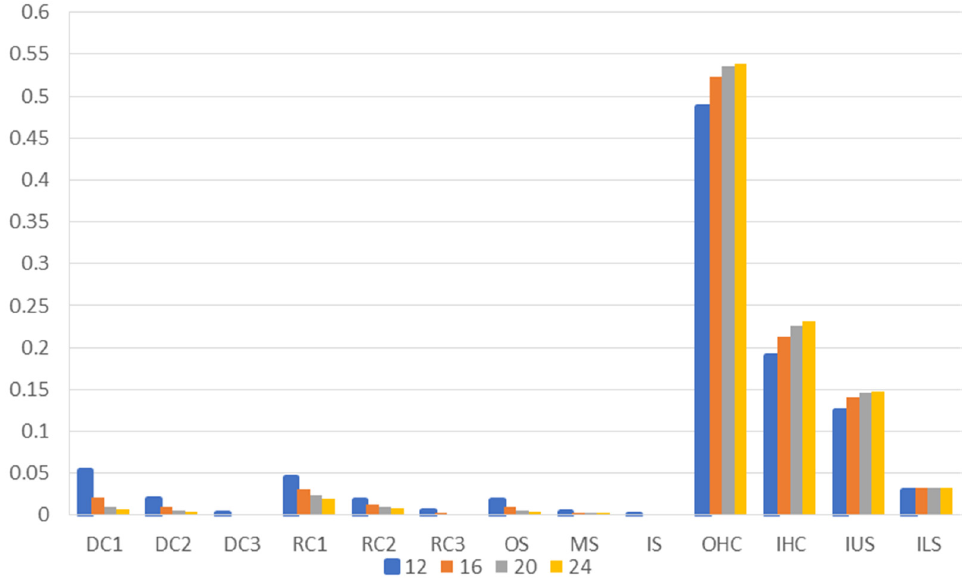
Figure 10. Variations in the importance coefficients of the elements with the number of structural